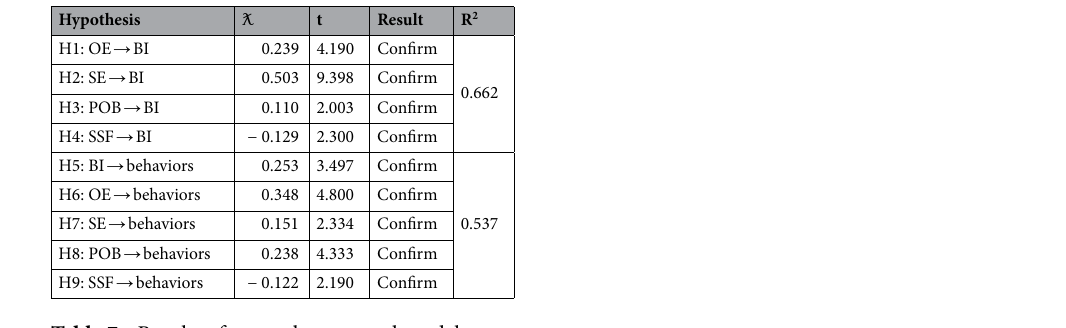
Table 7. Results of research structural